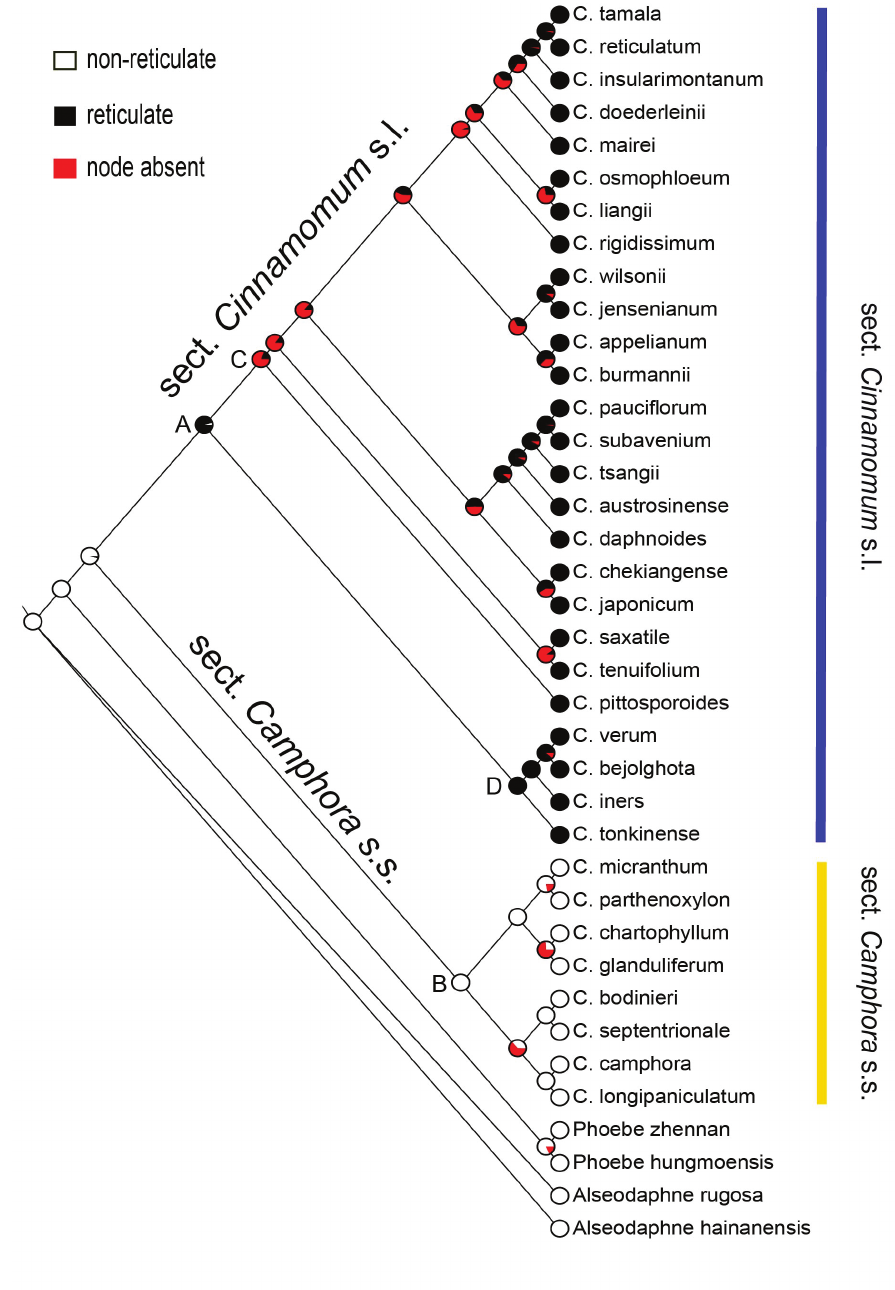
Figure 10. Ancestral character reconstruction of the periclinal wall reticulation by applying a ML tree block in Mesquite with a maximum likelihood approach and MK1 model. The common ancestor of Node A possesses reticulate periclinal wall with high likelihood (95.18%), and the ancestral Node B is reticulate with high likelihood